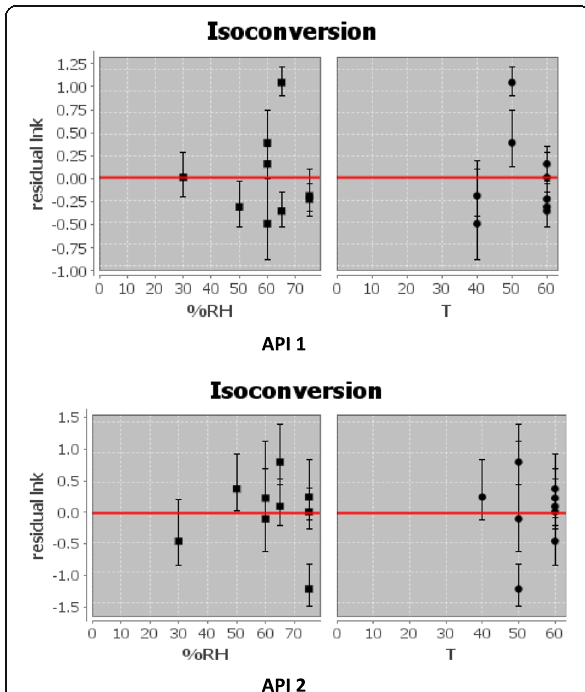
Fig. 3 Residuals for the Predicted Isoconversion Values for the Two Active Pharmaceutical